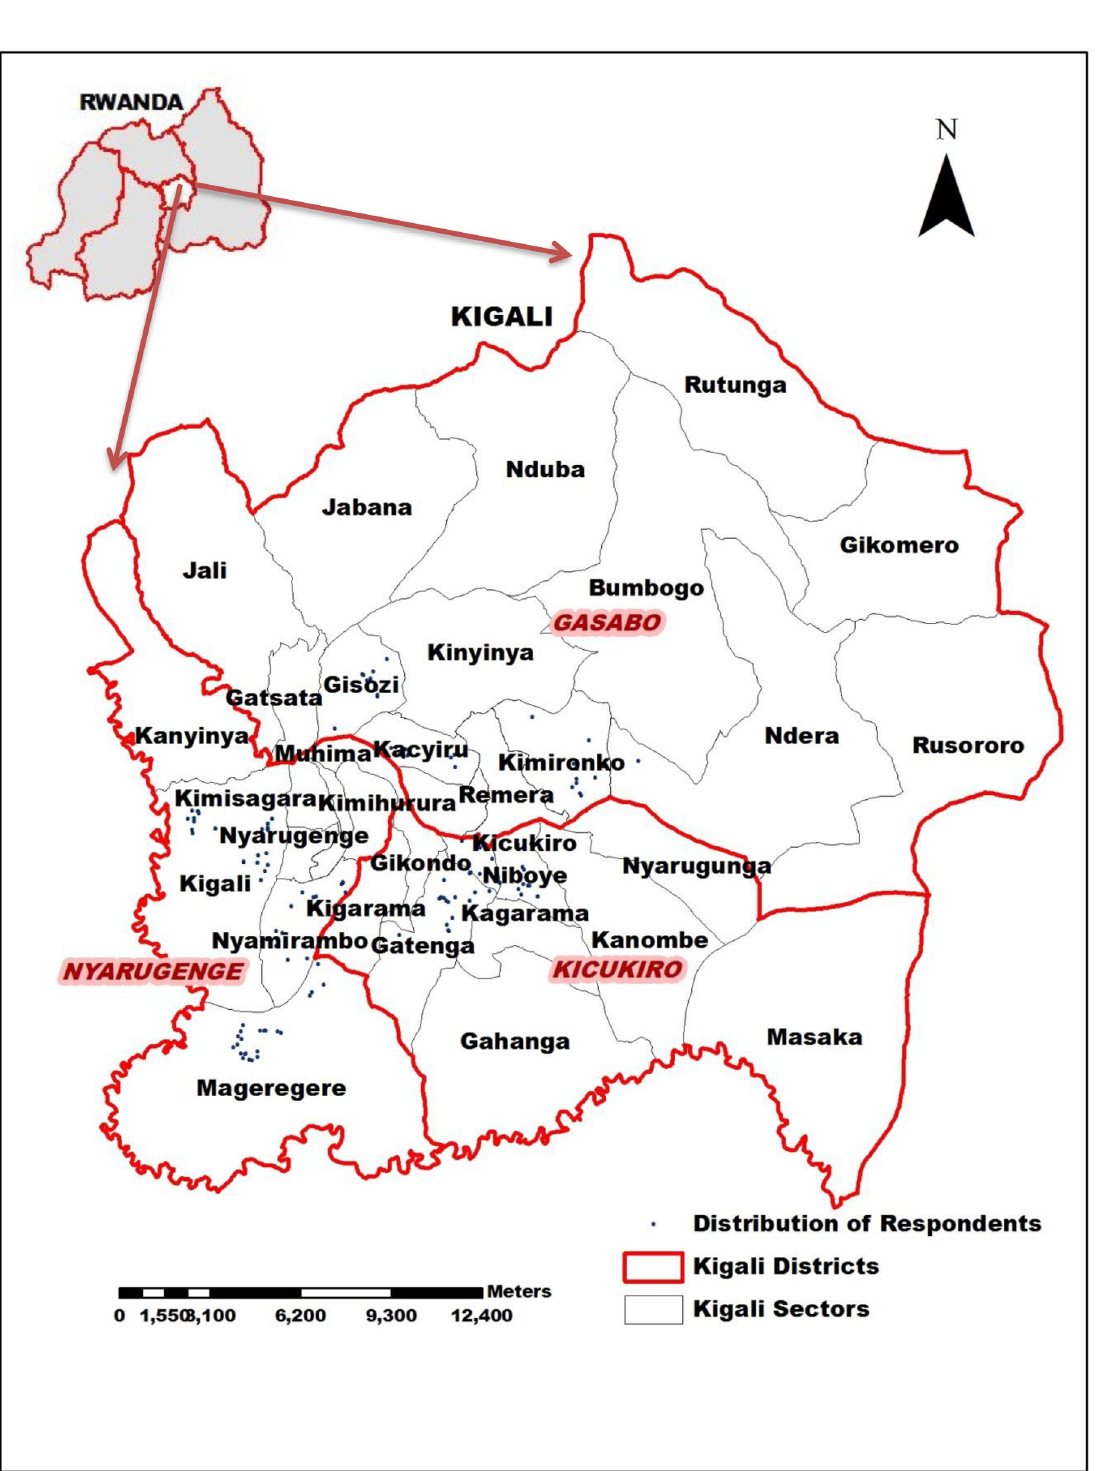
Fig 1. “Fig 1” illustrates names of the three administrative districts of Kigali city which are coloured in red, while those of its administrative sectors are coloured in gray. The blue points represent the respondent homes. The nine study sectors are Mageragere, Nyamirambo and Kigali in Nyarugenge district; Gatenga, Niboye and Kicukiro in Kicukiro district, and Kacyiru, Kimironko and Gisozi in Gasabo district. During this study, GPS data were collected on the location of each respondent’s household. ArcGis10.2 software was used to produce the map based on the GPS